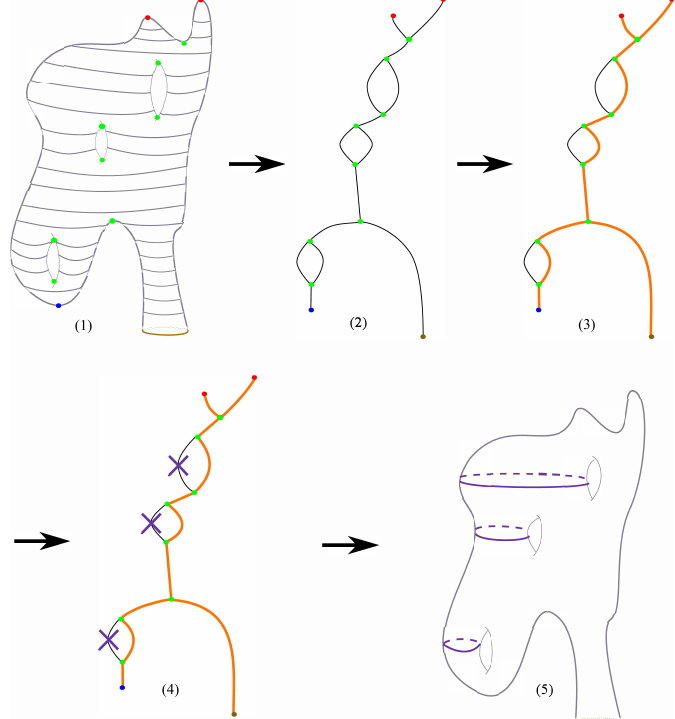
Figure 20. The steps of the cutting system algorithm. (1) mesh M with a scalar function defined on it are given. (2) The Reeb graph R ( M , f ) is computed. (3) We compute a spanning tree of R ( M , f ) . (4) We select all edges in the graph that do not belong the spanning tree we computed in (3) and then we select an interior point on each one of these edges. (5) For each interior point, we used our augmented Reeb graph algorithm to compute the circle that corresponds to it on the